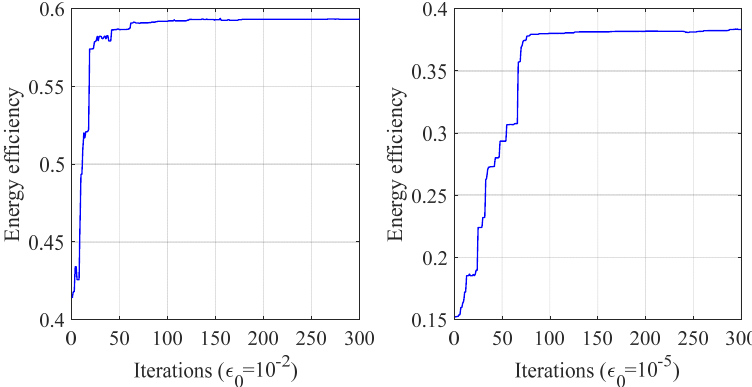
Figure 12. Energy efficiency optimization process based on a genetic algorithm.